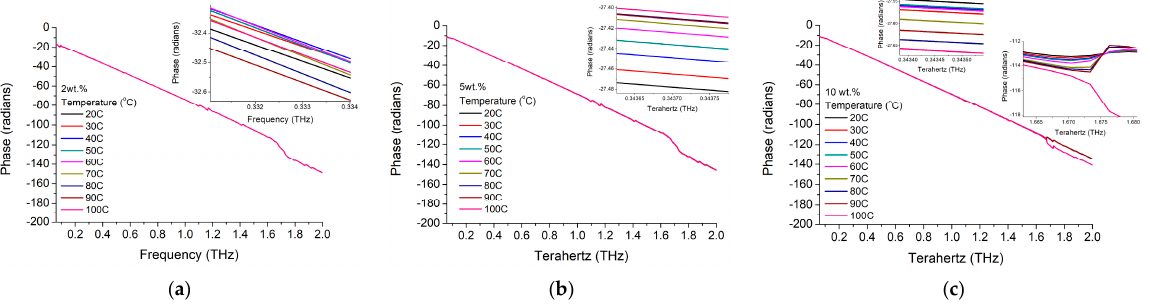
Figure 19. BTO-SBS phase variation with frequency for different BTO nanoparticle concentrations (( a ) 2 wt.%, ( b ) 5 wt.%, and ( c ) 10 wt.%) and different temperatures.